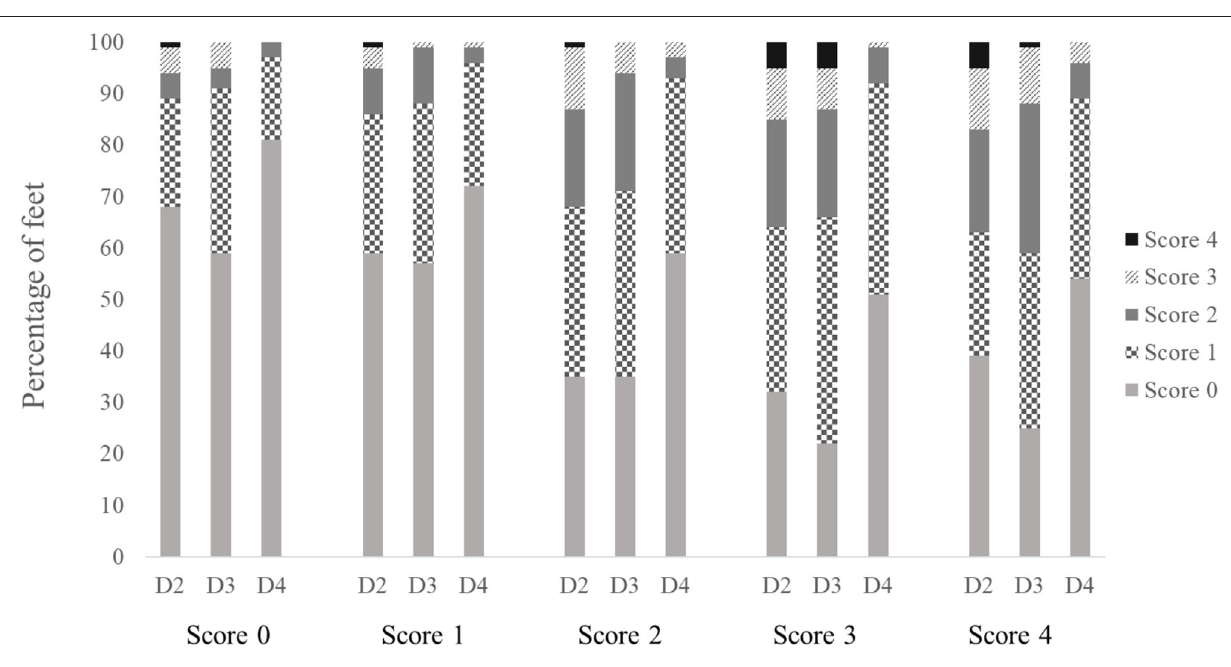
FIGURE 3 | Altered lesions on digital pads for the different scoring levels of the standard FPD scoring system of the metatarsal pad (score 0 = intact foot; score 1 = alterations ≤ 10%; score 2 = alterations ≤ 25%; score 3 = alterations ≤ 50% and score 4 = alterations > 50%). Digits were scored separately (D2–D4). Data are presented as percentage, n = 500